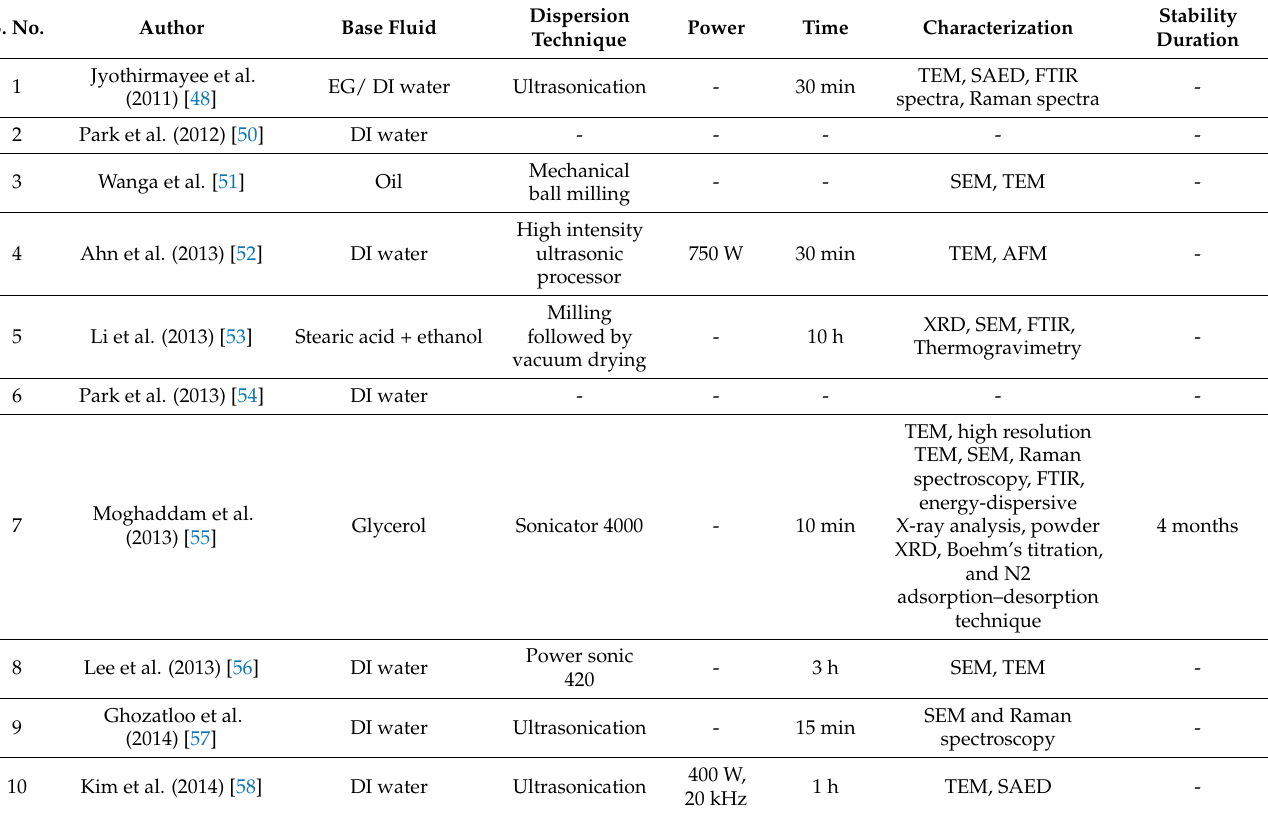
Table 4. Summary of published literature on synthesis of graphene nanofluids (mechanical